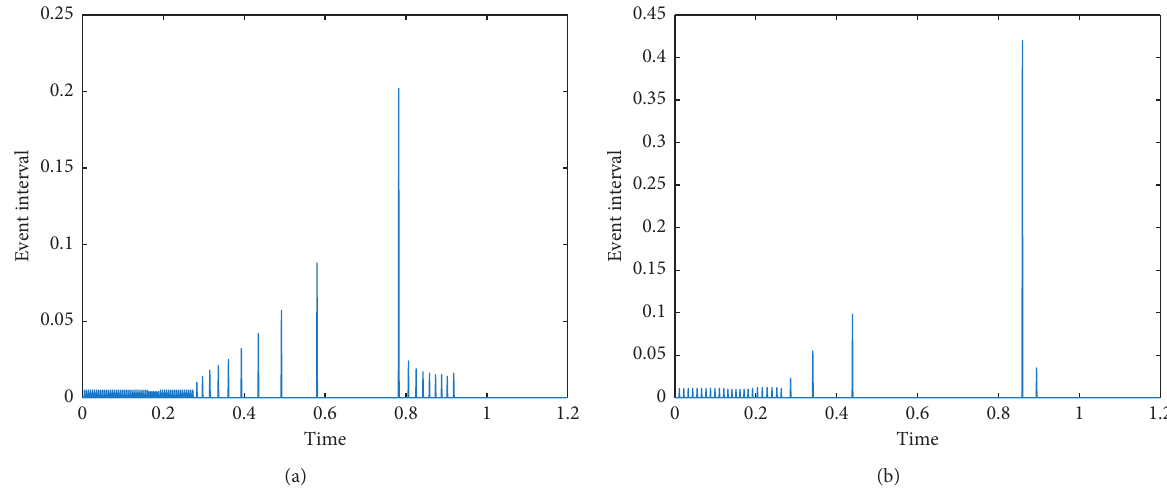
Figure 7: Release instants and event intervals under triggering condition (53) with ω � 0 . 25 and ω � 0 . 75.